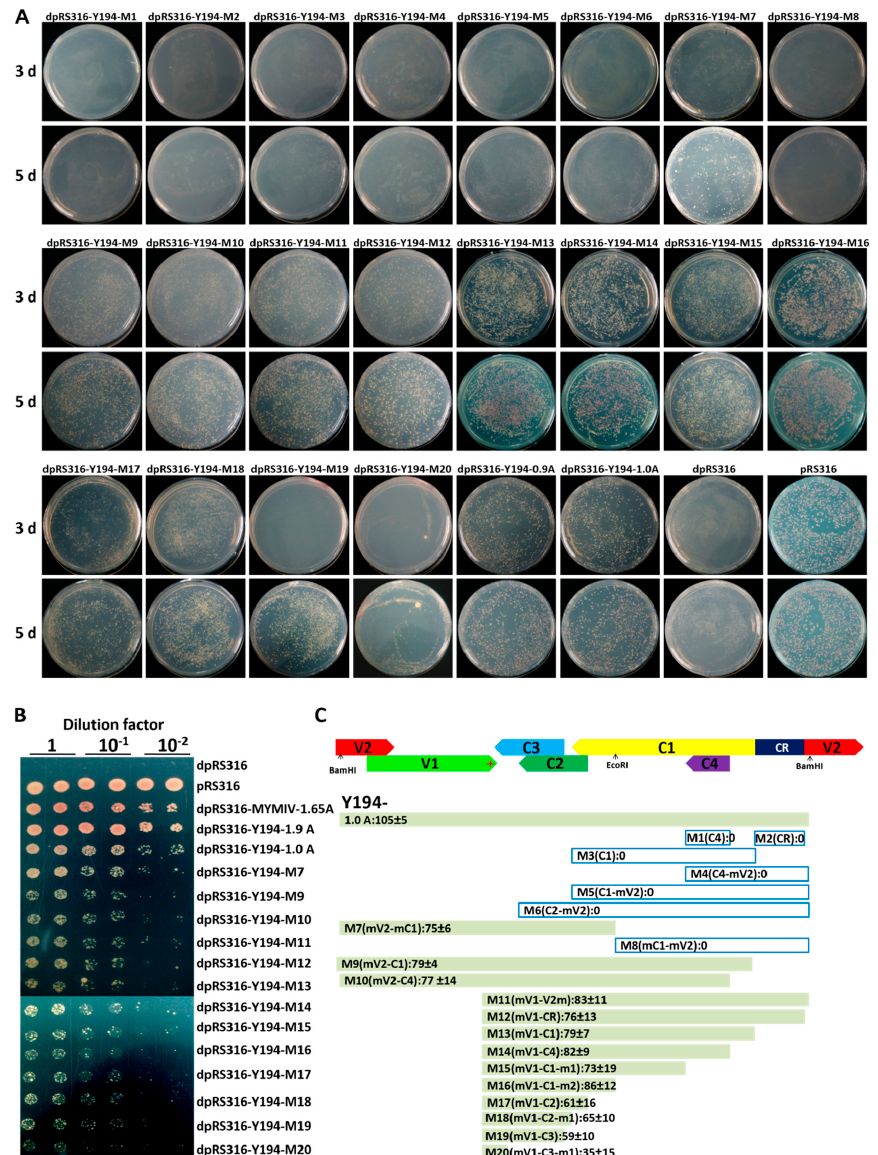
Figure 4. Identification of the yeast replication origin-like element sequences in the Y194 genome. ( A ) Recombinant plasmids dpRS316-(M1-M20) containing different fragments of Y194 viral genome DNA were transformed into W303-1B yeast cells, individually. Photographs were taken at 3 d and 5 d after transformation on the SC/–uracil plate. ( B ) The grown colonies of yeast cells transformed with pRS316, or dpRS316-Y194-1.0A,-M7, -M9-M16 from ( A ) were diluted on SC/–uracil. The yeast cells transformed with dpRS316-MYMIV-1.65A or dpRS316-Y194-1.9A were also used for positive controls, and yeast cells transformed with dpRS316 ( A ) as a negative control. ( C ) The diagrammatic sketch of different Y194 constructs and the average numbers of yeast colonies carrying the indicated plasmids. The genomic organization of Y194, including the common region (CR), the V2 open reading frame (ORF), the V1 ORF, the C3 ORF, the C2 ORF, the C1 ORF, and the C4 ORF located in the viral and complementary strands are indicated. The red star represents the position of ARS-like elements in Y194 genomic DNA sequences. Three independent transformations with the indicated plasmids ( A ) were performed, and the values represent the average numbers of yeast colonies (diameter > 2 mm) emerging on the SC/–uracil media after 5 d of